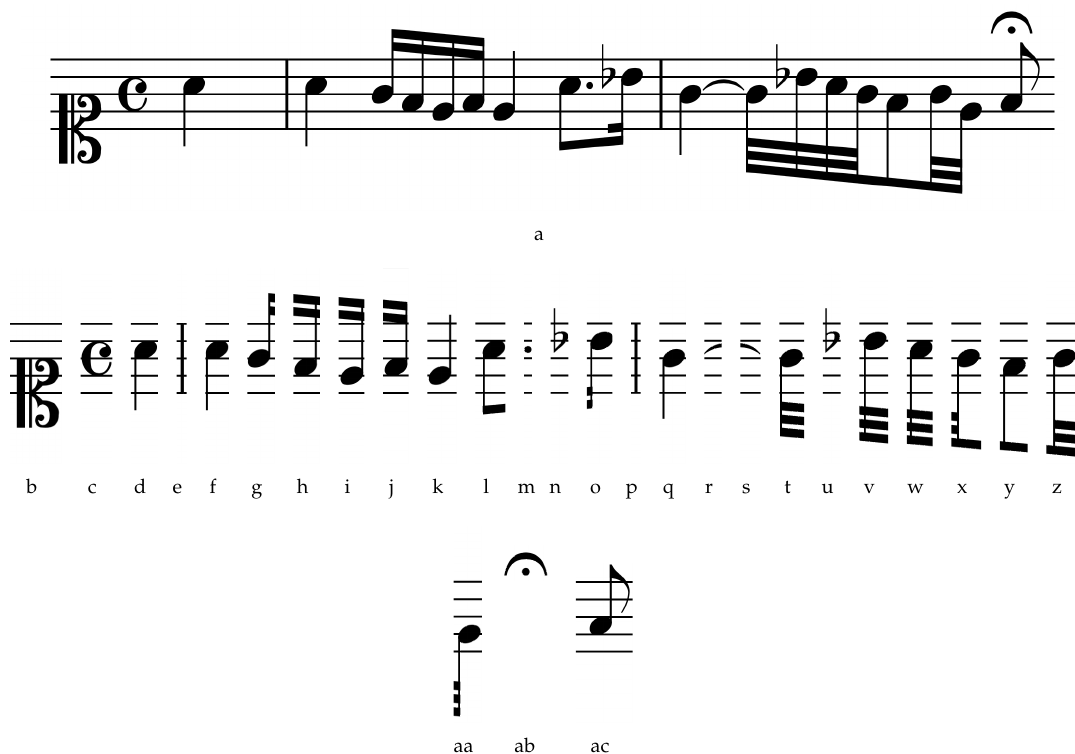
Figure 2. Graphical symbol division example. Elements are ordered left-to-right, top-down. (a) Incipit. RISM ID no. 000051806. Das alte Jahr vergangen ist . Johann Sebastian Bach; (b)–(ac) Symbol division; (ad) Agnostic